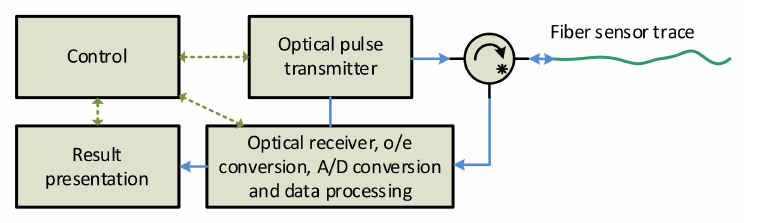
Figure 2. Block structure of the distributed fiber sensor utilizing signal backscattering